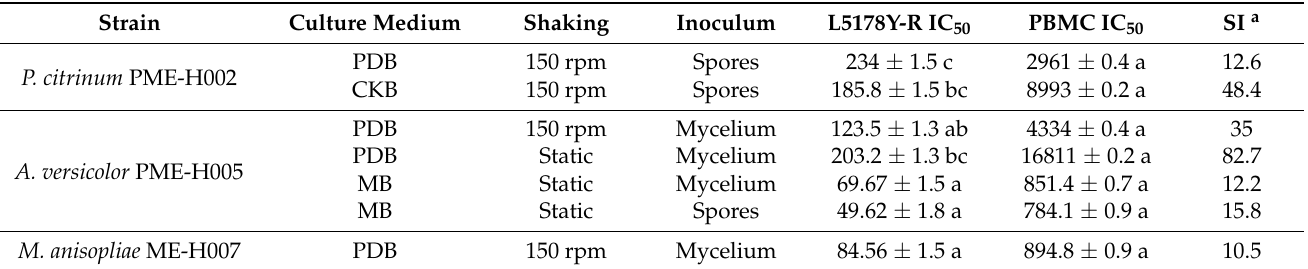
Figure 5. Percentage growth inhibition of Cladosporium sp. PME-H008 strain methanol extracts against L5178Y-R cells in different media and culture conditions. ( A ) PDB, ( B ) CKB, and ( C ) MB. Data represent the mean ± SD of three replicate determinations from three independent experi- ments. * p < 0.05, ** p < 0.01, as compared with the untreated control, using the Kruskal–Wallis test. Sh, shaking; St, static; M, mycelium; S, spore. Table 2. IC 50 ( µ g/mL) and SI of L5178Y-R cells and PBMC treated with L. marginatus fungal endophyte methanol extracts from different culture conditions.